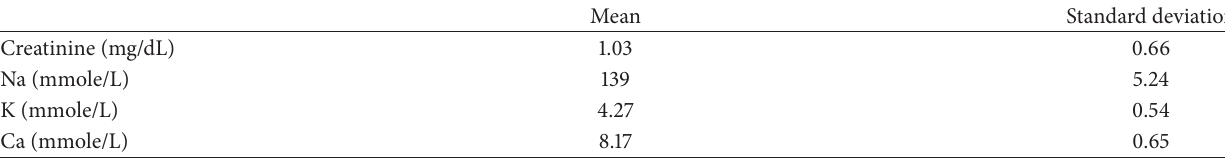
Table 3: Mean and standard deviation of some laboratory results in study patients.